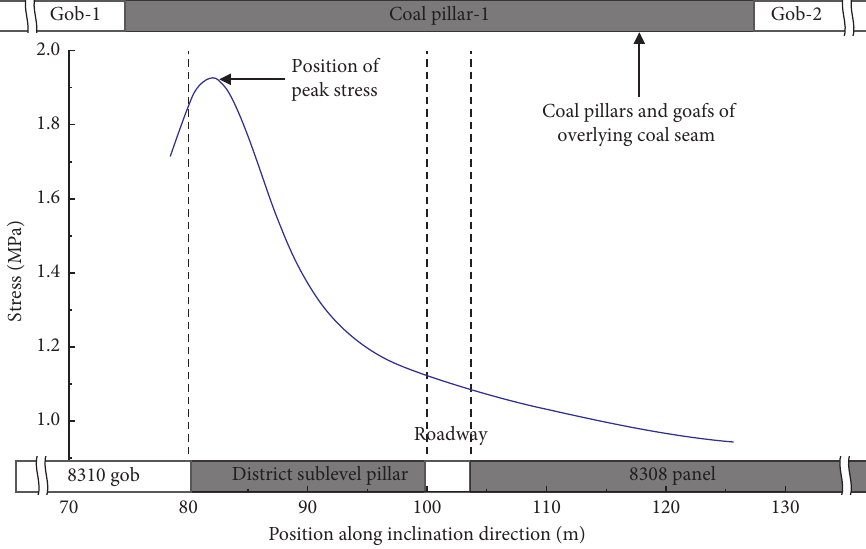
Figure. 13: Lateral abutment pressures at Section